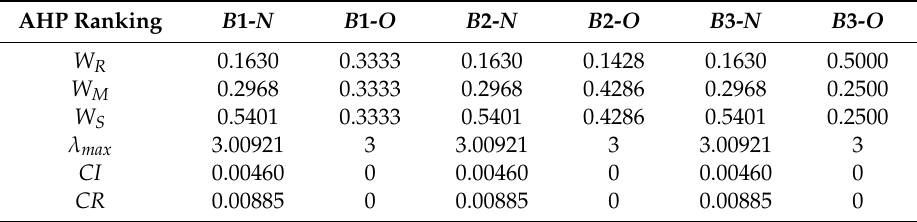
Table 7. Results of the ranking of the indicators of the analyzed